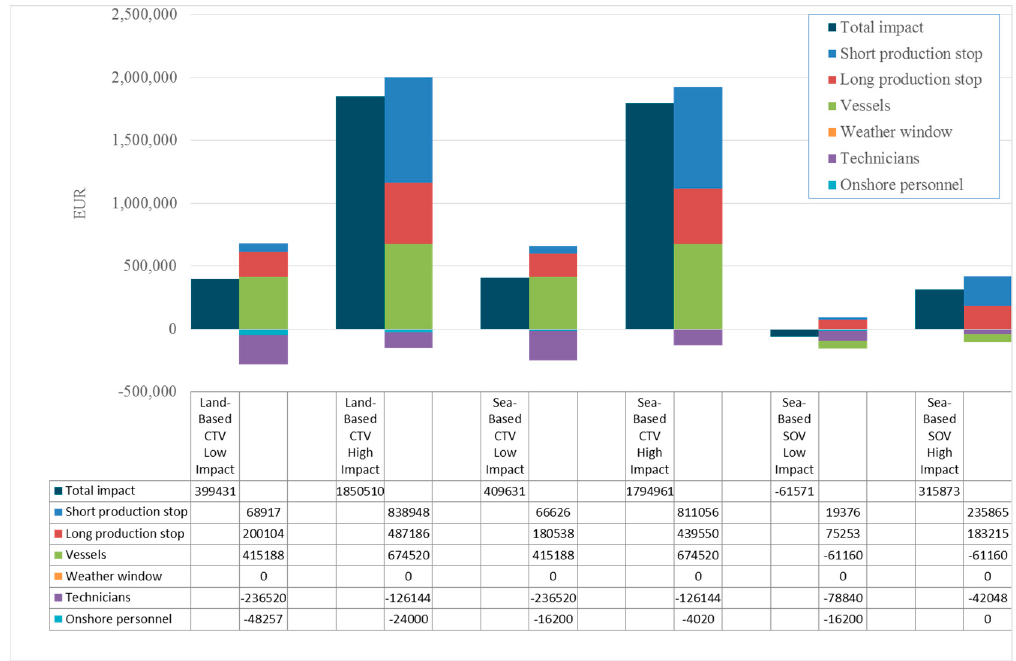
Figure 5. Business case outcome for working 12/7 (left columns, daytime only) and 24/7 (right columns, daytime and at night) for three cases (land-based CTV, sea-based CTV and sea-based SOV) for low and high impact estimates.